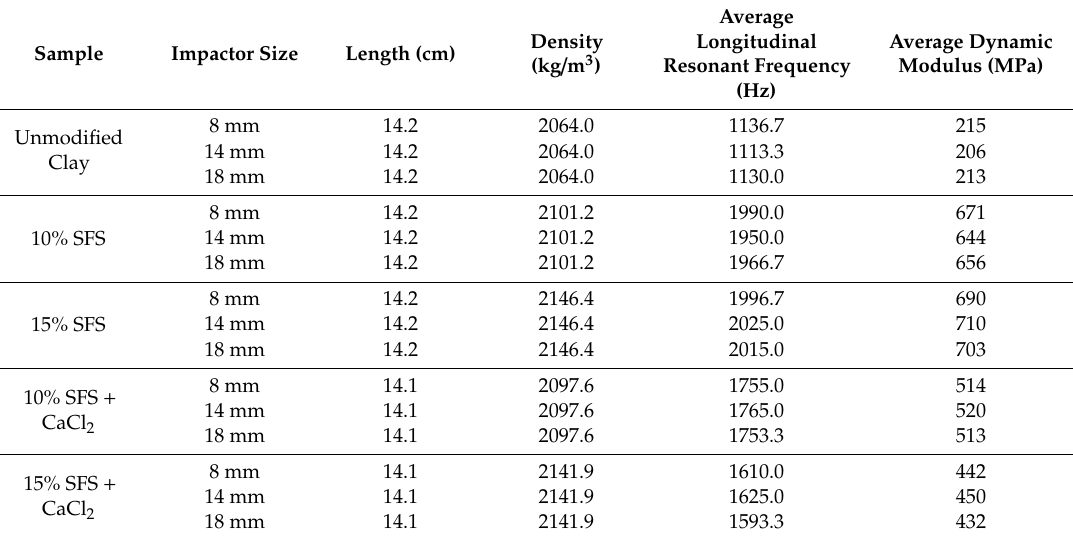
Table 10. Longitudinal dynamic modulus for each